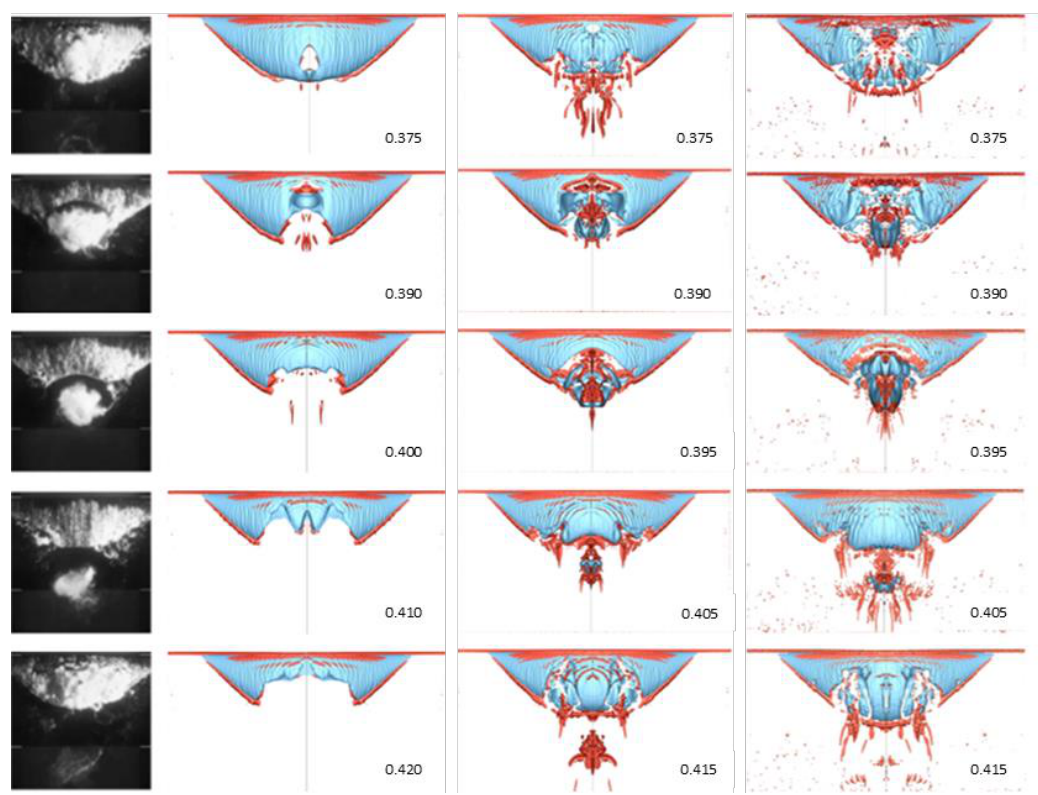
Figure 5. Comparison of RANS ( left ), DES ( middle ), and LES ( right ); iso-surfaces show the volume fraction α = 0.5 and Q-criterion.